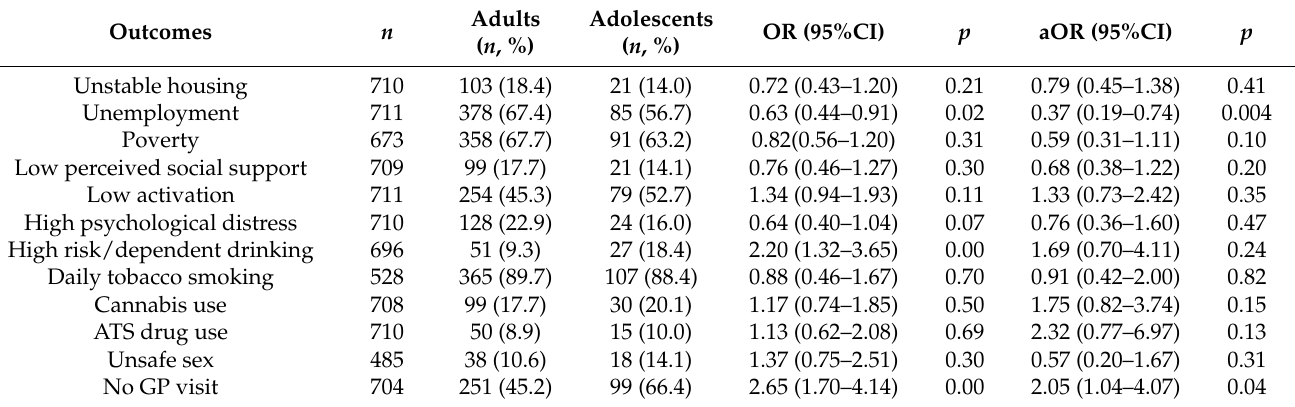
Table 2. Associations between age and key outcomes at 3 month